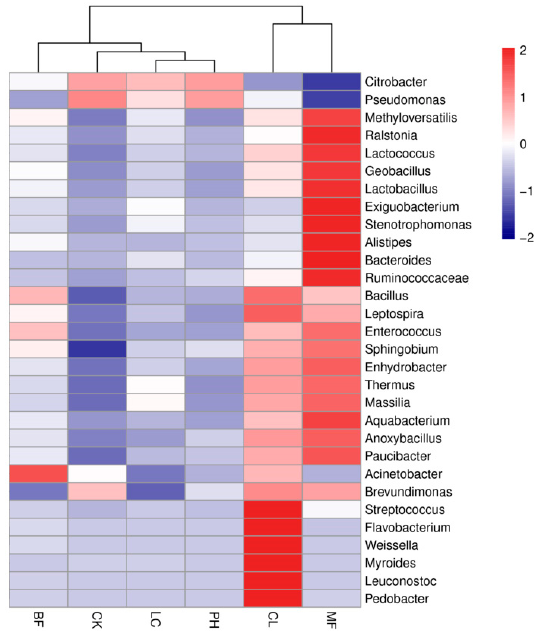
Figure 4. Heatmap of relative abundances across a wide range of forest types. Forests are clustered based on the percent relative abundance of the genus-level classifications shown as rows. Each row was scaled so that the mean of each taxonomic group across sample types was calculated and colored by the corresponding z-score of each cell.